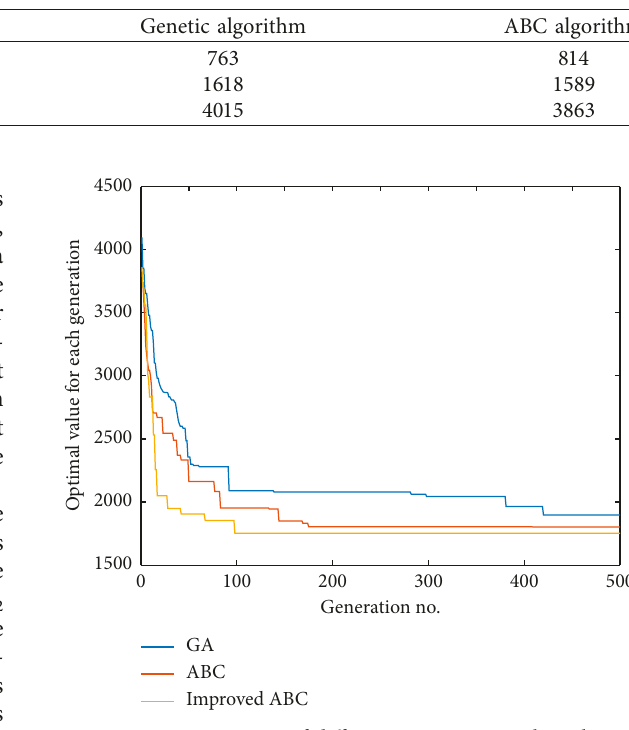
Figure 7: Comparison of different optimization